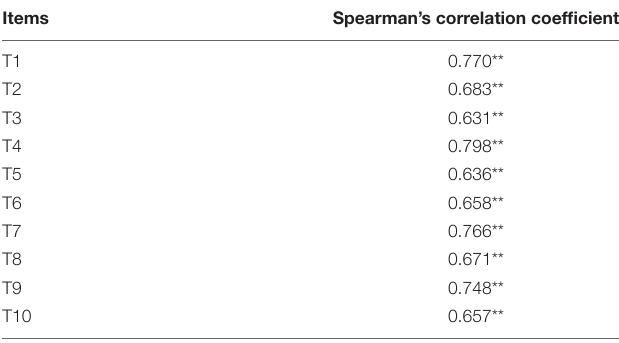
TABLE 2 | Correlation between each item and the total score.